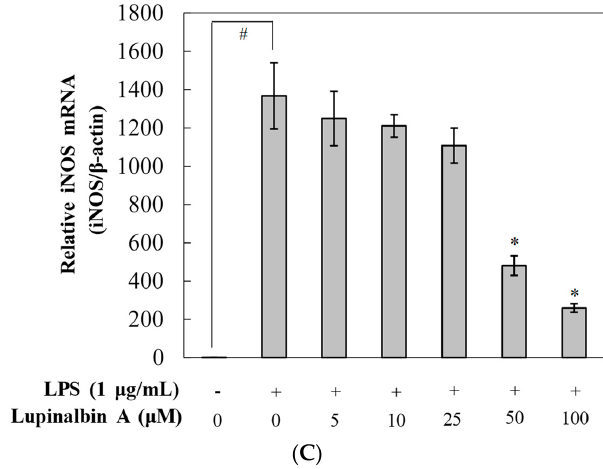
Figure 2. Effect of lupinalbin A on NO production and iNOS protein and iNOS mRNA expression in LPS-treated RAW264.7 cells. ( A ) Cells were treated with various concentrations of lupinalbin A (5–100 µM) for 2 h and then incubated with LPS (1 µg/mL) for 18 h. The data are presented as mean ± SDs ( n = 6). # p < 0.05 vs. control group, * p < 0.05 vs. LPS-treated group; ( B ) iNOS protein levels were measured by western blot; ( C ) Cells were treated with various concentrations of lupinalbin A (5–100 µM) for 2 h and then stimulated with LPS (1 µg/mL) for 18 h. iNOS mRNA expression levels were measured by qRT-PCR. The data are presented as mean ± SDs ( n = 3). # p < 0.05 vs. control group, * p < 0.05 vs. LPS-treated group.